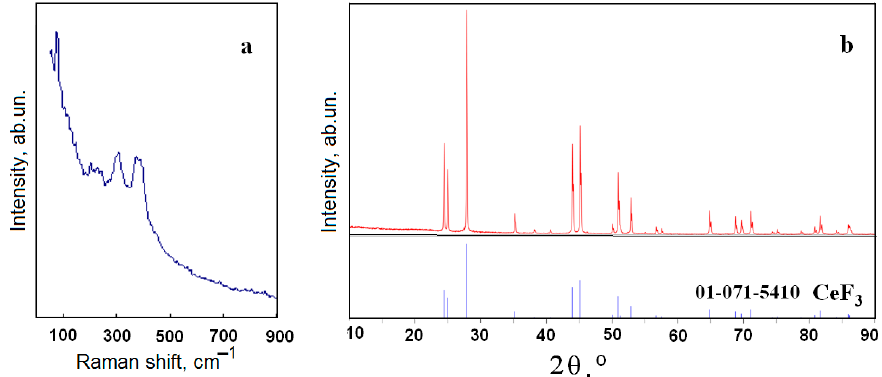
Figure 1. Raman spectrum ( a ) and XRD analysis ( b ) of the cerium fluoride.